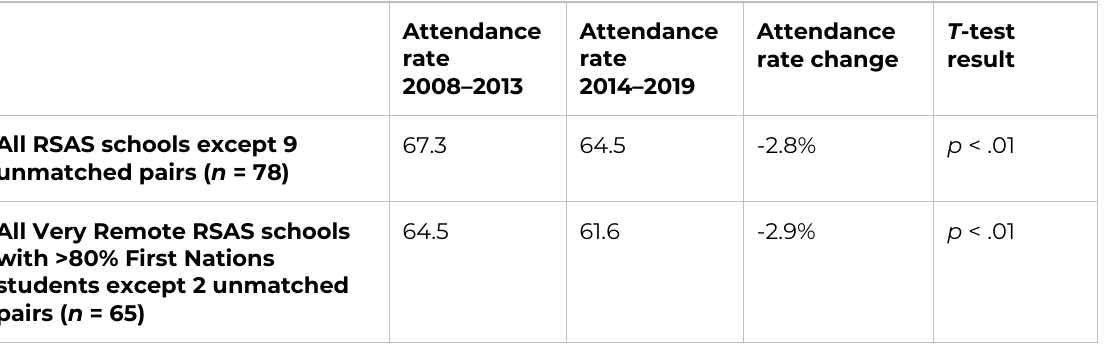
Table 3: Term 1 school attendance rates for RSAS schools 2008–2013 compared with